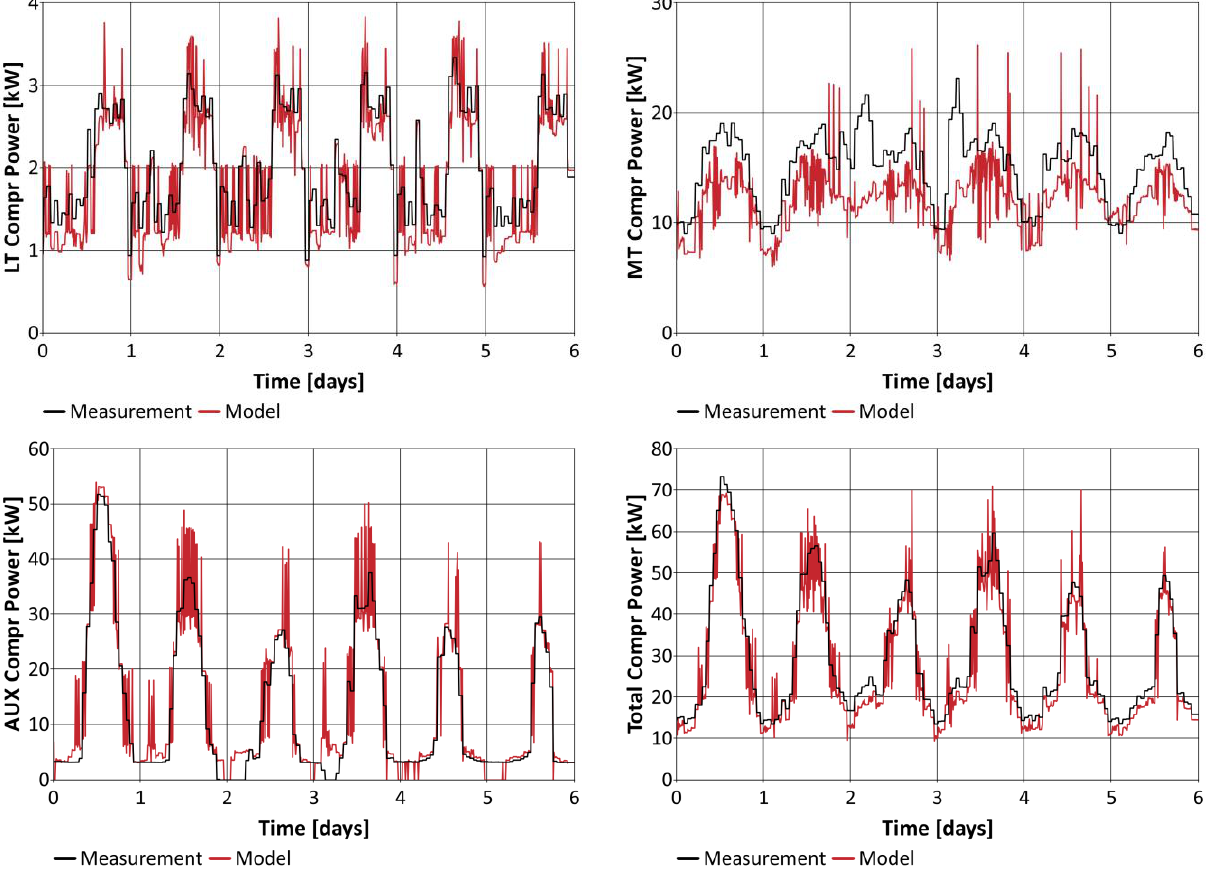
Figure 9. Validation results for the system model based on measurements for the system operating with HP ejector block during a summer week in 2019 (week 34); comparison between measured (black) vs. calculated (red) power consumption for LT, MT, and AUX compressors, as well as the total for all compressor groups.